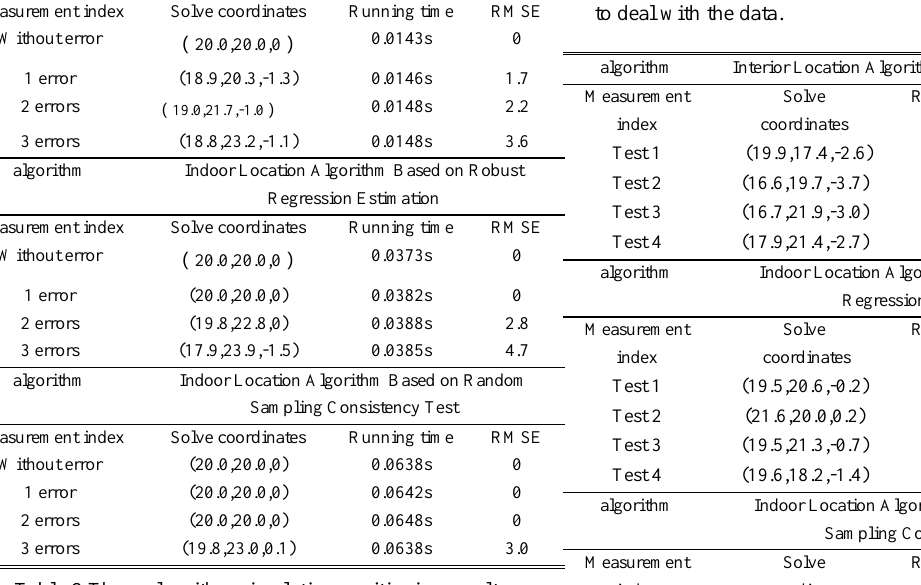
Table 2 Three algorithm simulation positioning results